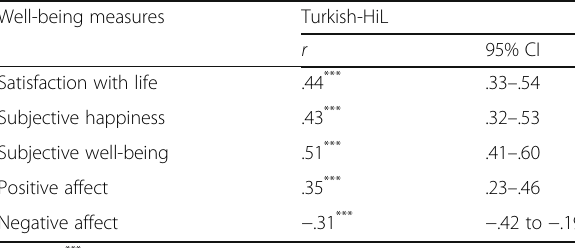
Table 3 Correlations of The Turkish-HiL and the Other Well- Being Scales with Confidence Intervals Well-being